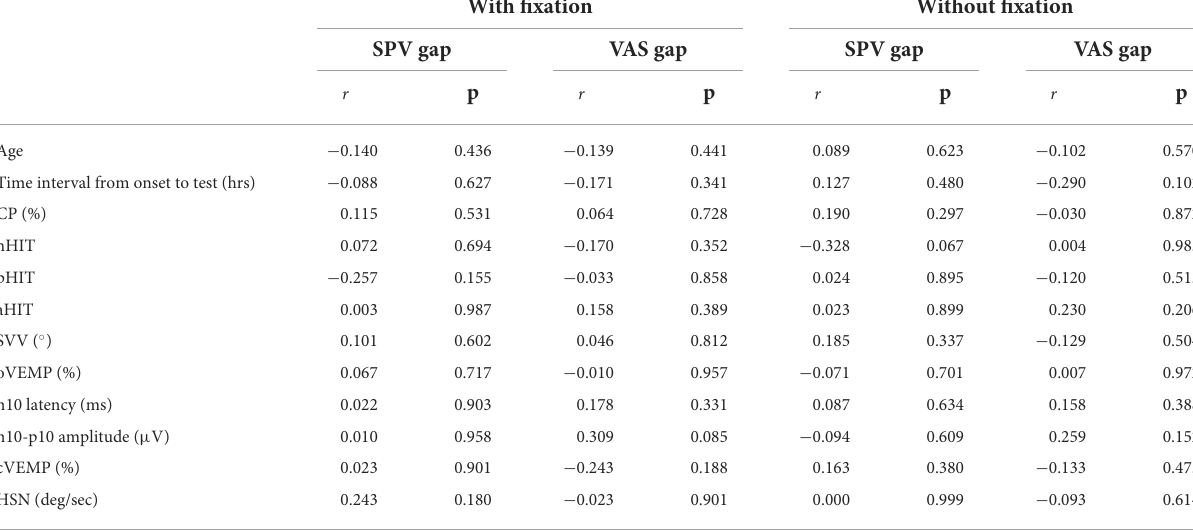
TABLE 4 Correlation analysis of the gap of vertigo severity (VAS gap) and the gap of the intensity of spontaneous nystagmus (SPV gap) while lying on the lesion and healthy sides with vestibular function test results. With fixation Without